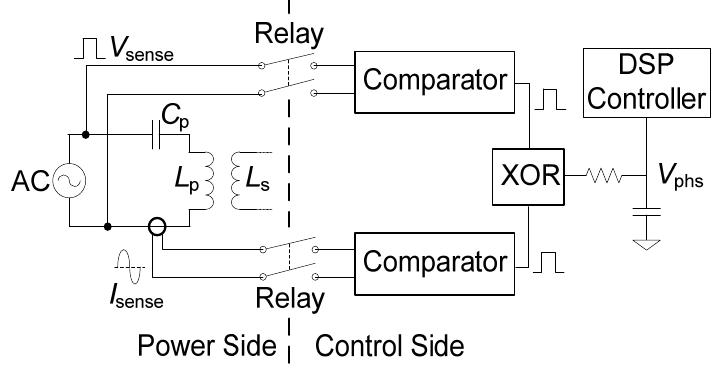
Figure 2. Schematic of phase angle